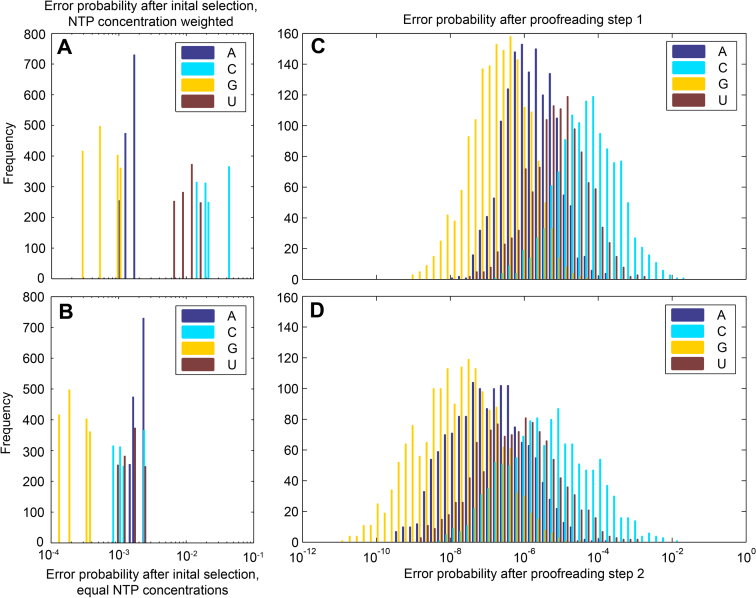
Histograms of error probability after initial selection, proofreading step 1 and proofreading step 2 in rrnC. The histograms show the frequency of positions within the operon with en error probability within the scope of the bar. The data are grouped by the cognate substrate X, and with only one type of mismatch per template (A·A, C·C, G·G or U·T), panels A–C represents the error probability of the mismatch Y·Y compared to the correct X·Y. (A) Error probability after initial selection. The distribution is discrete, since the variation comes from only 2 bp. The error probability is nucleotide concentration weighted to show the probabilities of errors before proofreading. (B) Error probability after initial selection without nucleotide concentration weighting, representing the initial selection discrimination as expressed in Equation (7). (C) Error probability after initial selection and the first step of proofreading. This proofreading step gets the benefit of both polymerase effects. (D) Error probability after initial selection and two steps of proofreading. The second proofreading step is enhanced only by the polymerase effect on cleavage. The accuracy amplification by revisiting positions is not included in any panel.